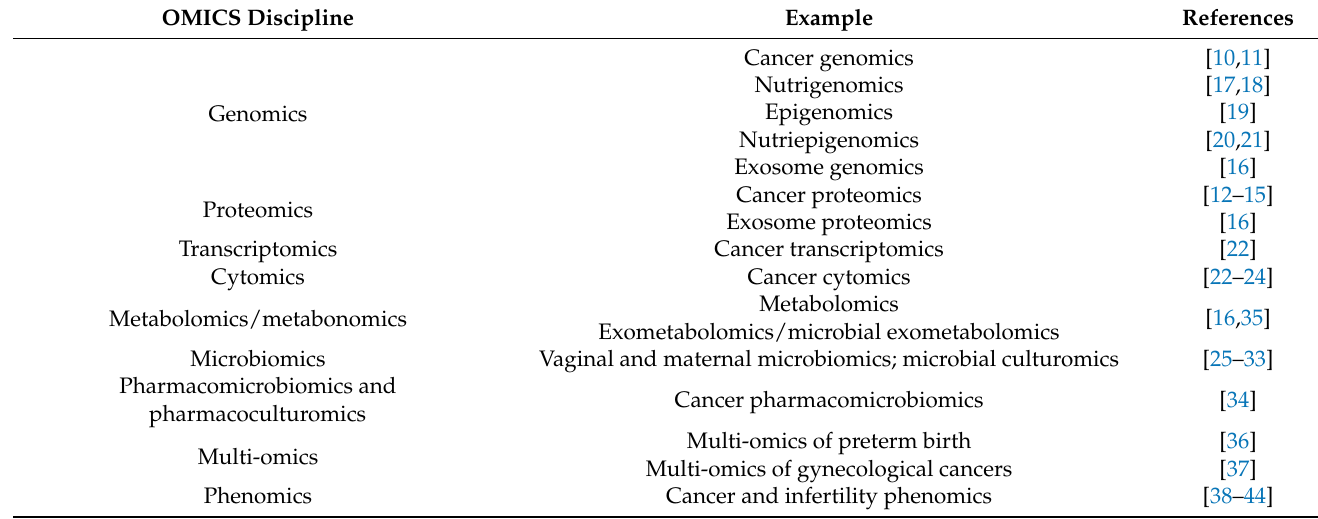
Table 2. An overview of the main OMICS disciplines useful for gynecologists and scholars working in the field of human female reproductive health: bridging the gaps from genomics to phenomics, combining/merging the various specialties via multi-OMICS